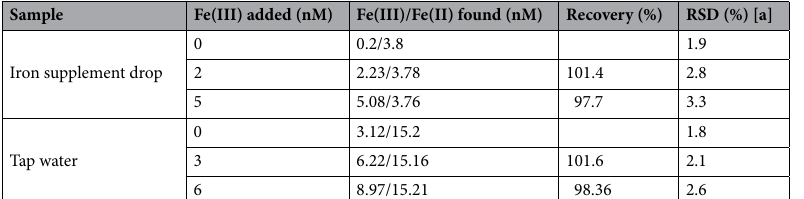
Table 2. Results for the determination of Fe(III)/Fe(II) in drug and water samples.